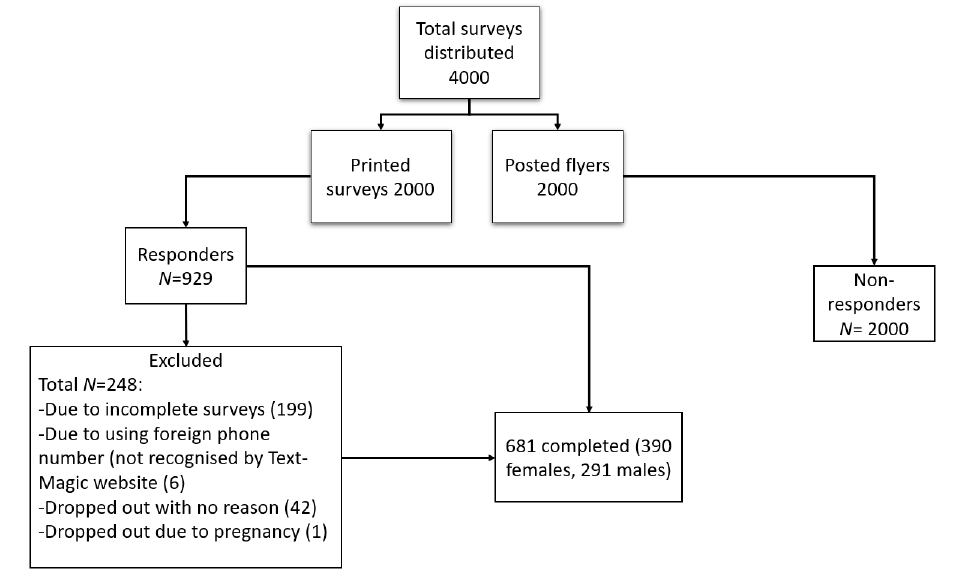
Figure 1. Flow chart of inclusion and exclusion of participants.